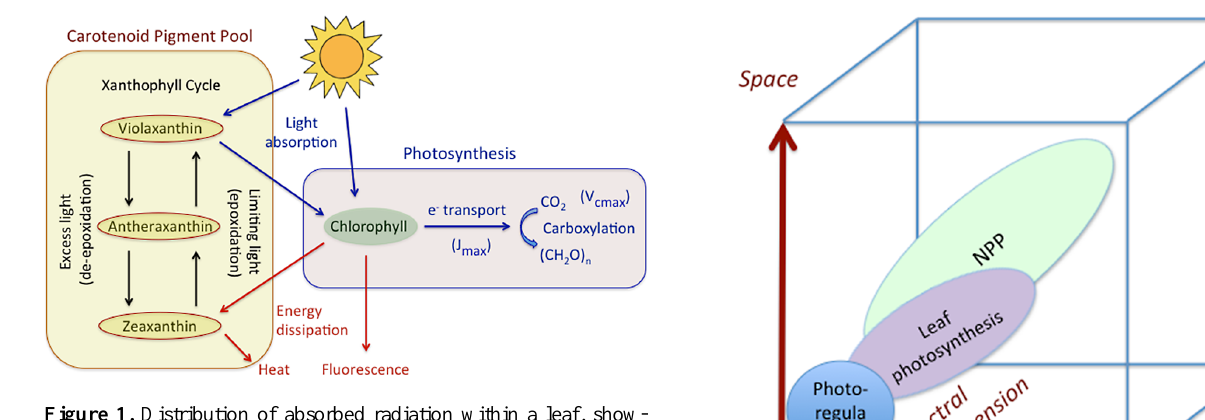
Figure 1. Distribution of absorbed radiation within a leaf, show- ing processes of productive photosynthesis (blue text and arrows), energy dissipation (red text and arrows), regulatory processes asso- ciated with the xanthophyll cycle (black text and arrows within box on left), and carotenoid and chlorophyll pigment pools, all of which can be assessed with optical sampling, but at different temporal, spatial and spectral scales, as discussed in the text.